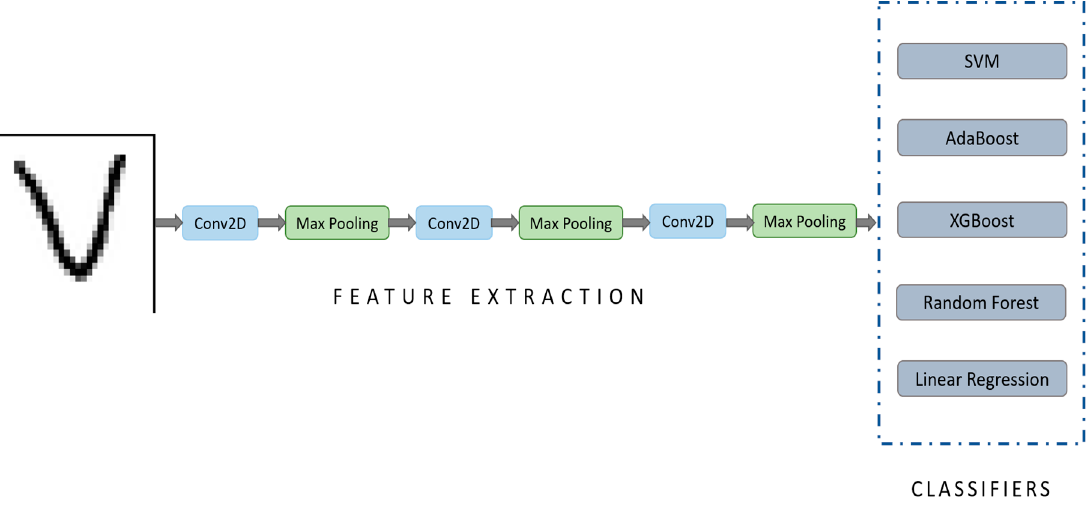
Figure 4. The architecture of the hybrid models.